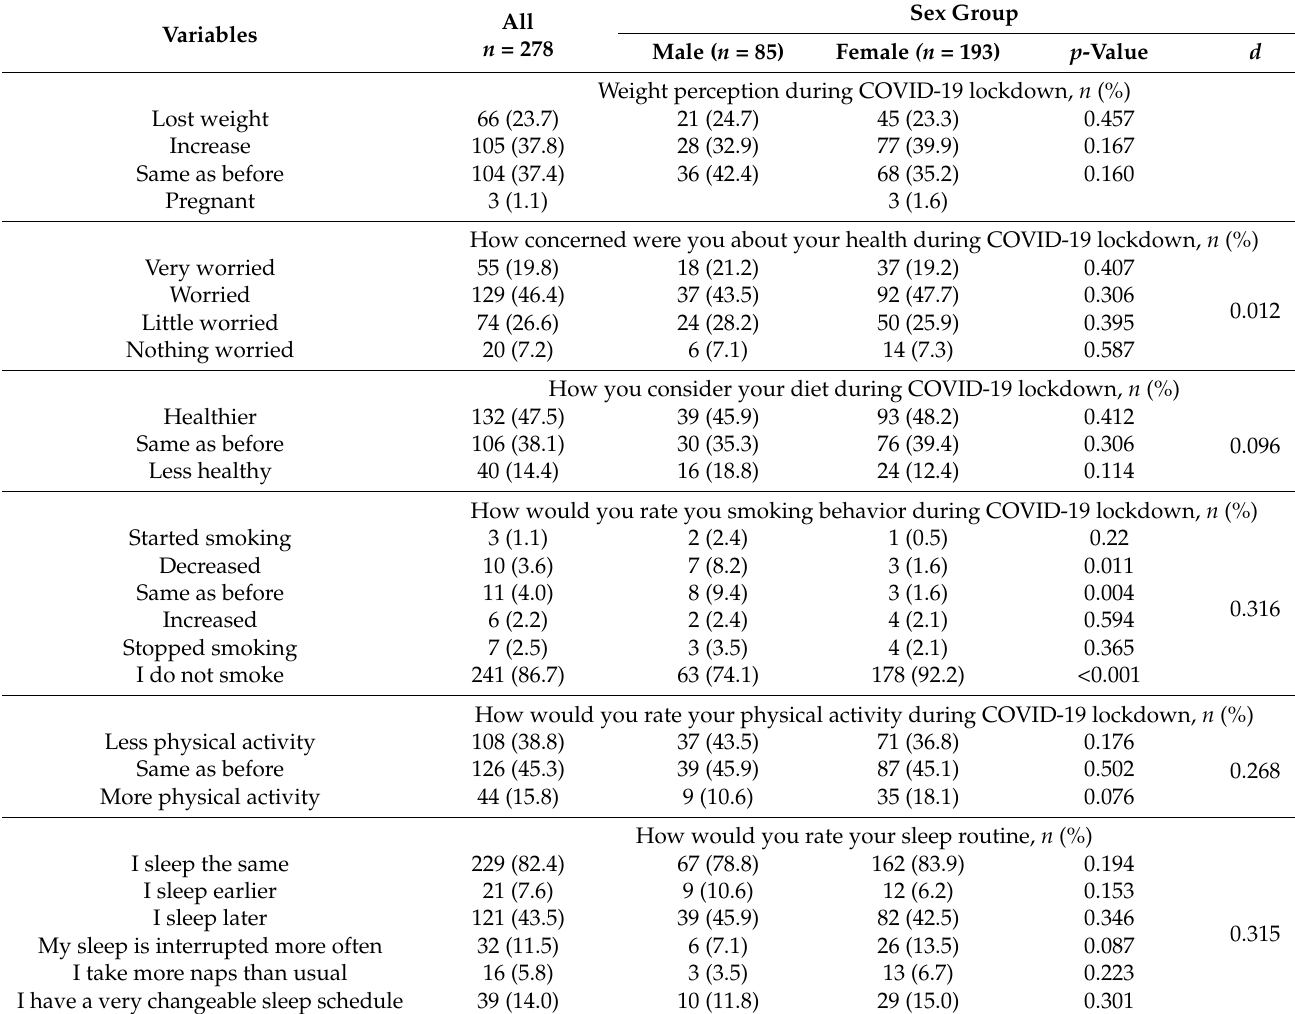
Table 3. Additional questions on health and lifestyle changes during COVID-19 lockdown by gender ( n =